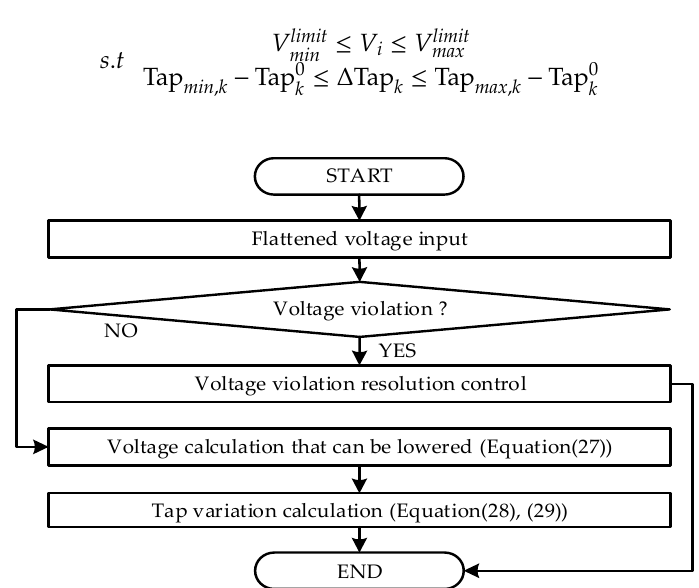
Figure 14. Flowchart for proposed tap control method for CVR.